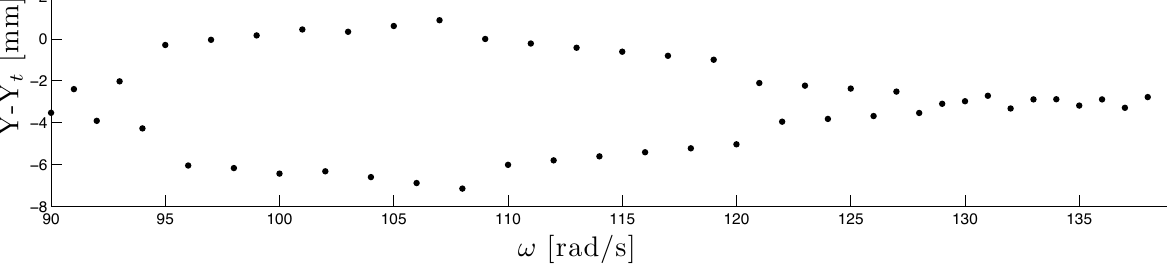
Fig. 13 Bifurcation diagram with respect to the angular frequency ω for parameters m t = 25 kg and b t = 500 N s m − 1 .